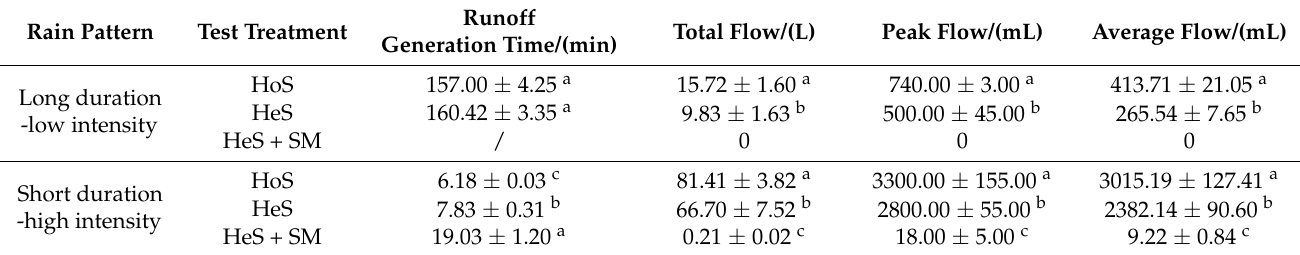
Table 3. Effect of straw mulching on surface runoff of Red Soil Sloping Farmland. Rain Pattern Test